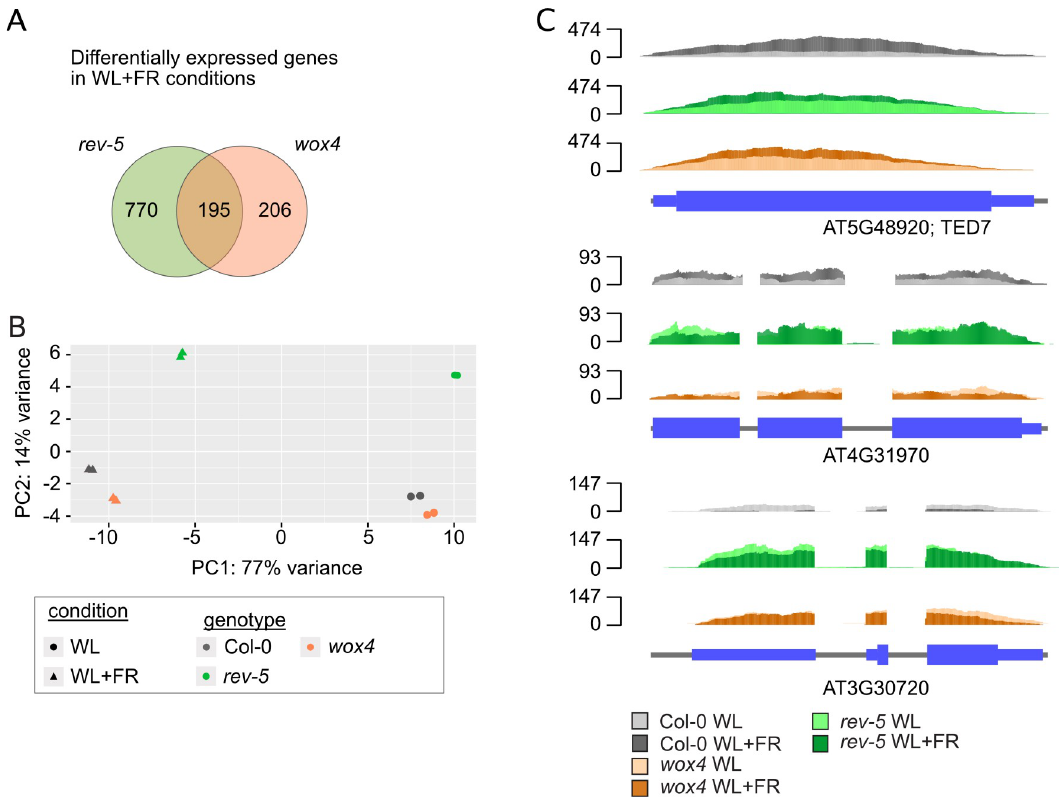
Fig 5. Shade-induced transcriptome changes in vascular patterning mutants. A , Venn diagram depicting differentially expressed genes (DEGs) in response to shade in the different genetic backgrounds (log2FC > +1/-1, BH-adj. p-value < 0.01). B , Principle component analysis of the gene expression (regularized logarithm transformed count data) between the different RNA-seq libraries. Plotted is the percentage of variance for each component. C , RNA-Seq read coverages of representative candidate genes showing the expression levels in the different genetic backgrounds. Upper panel shows a gene ( AT5G48920 ; TED7 ) that is expressed at higher levels in WL in rev-5 and wox4 ; the middle panel depicts a gene ( AT4G31970 ) that is more robustly expressed in rev-5 and much lower in wox4 while the lower panel depicts a gene ( AT3G30720 ) that is higher expressed in the mutant plants compared to wild